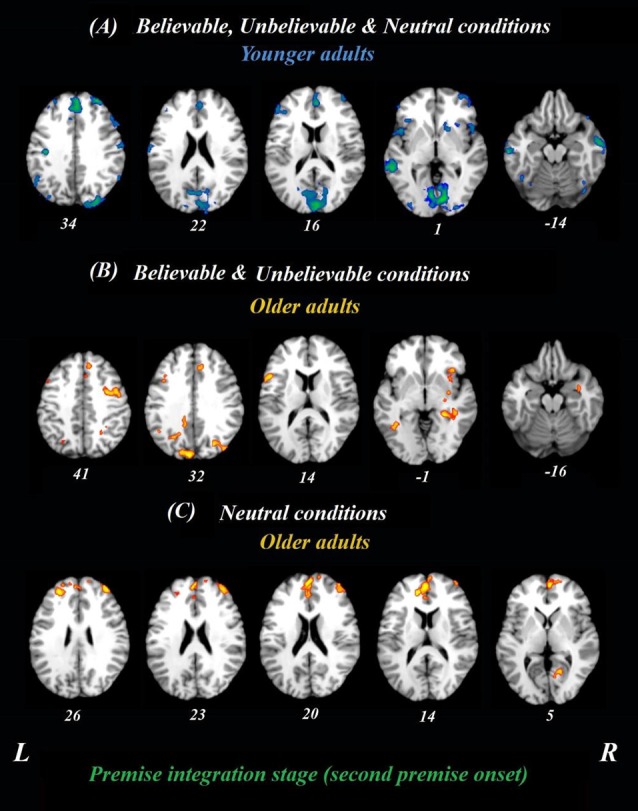
Whole-brain results during the premise integration stage in both age groups. Onsets of the second premise were used in this analysis using task PLS. All believable, unbelievable, and neutral premises were included in this analysis. (A) Younger adults recruited the blue regions similarly for all conditions during the premise stage. (B) Older adults, however, recruited yellow regions more during unbelievable and believable premises. (C) These regions were more involved during neutral premises relative to other conditions among older adults. All reported regions have a bootstrap ratio of ≥2.5 and cluster size ≥50 voxels. Abbreviations: L, left hemisphere; R, right hemisphere.